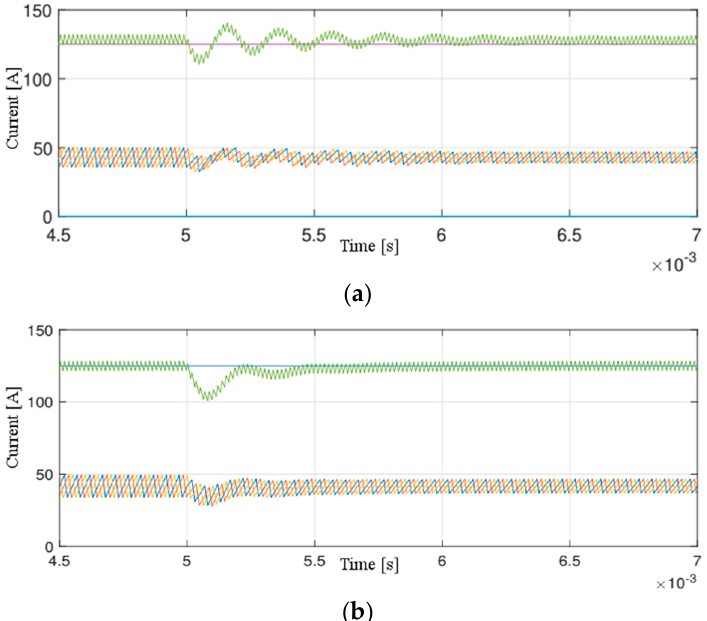
Figure 14. (green), reference (light blue), and inductors (blue, yellow, and red) currents under 10% V in variation with the method proposed in [13] ( a ) and with the method proposed in this paper ( b ).